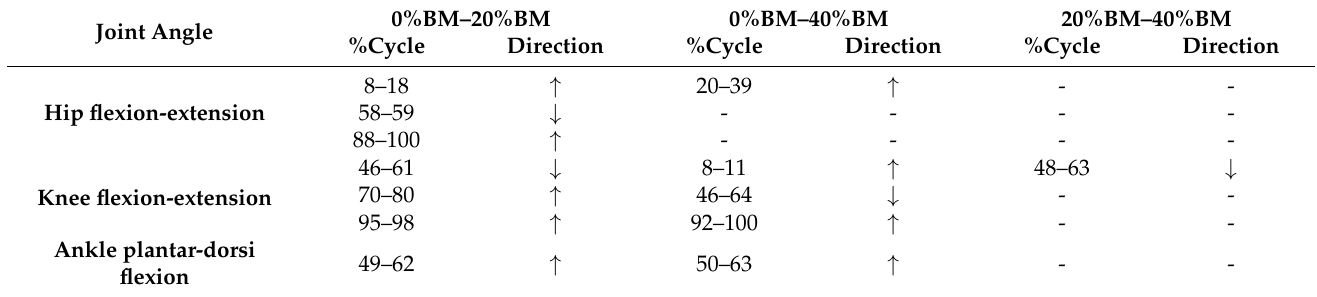
Table A1. Overview of the direction and timing of kinematic changes between loading conditions.